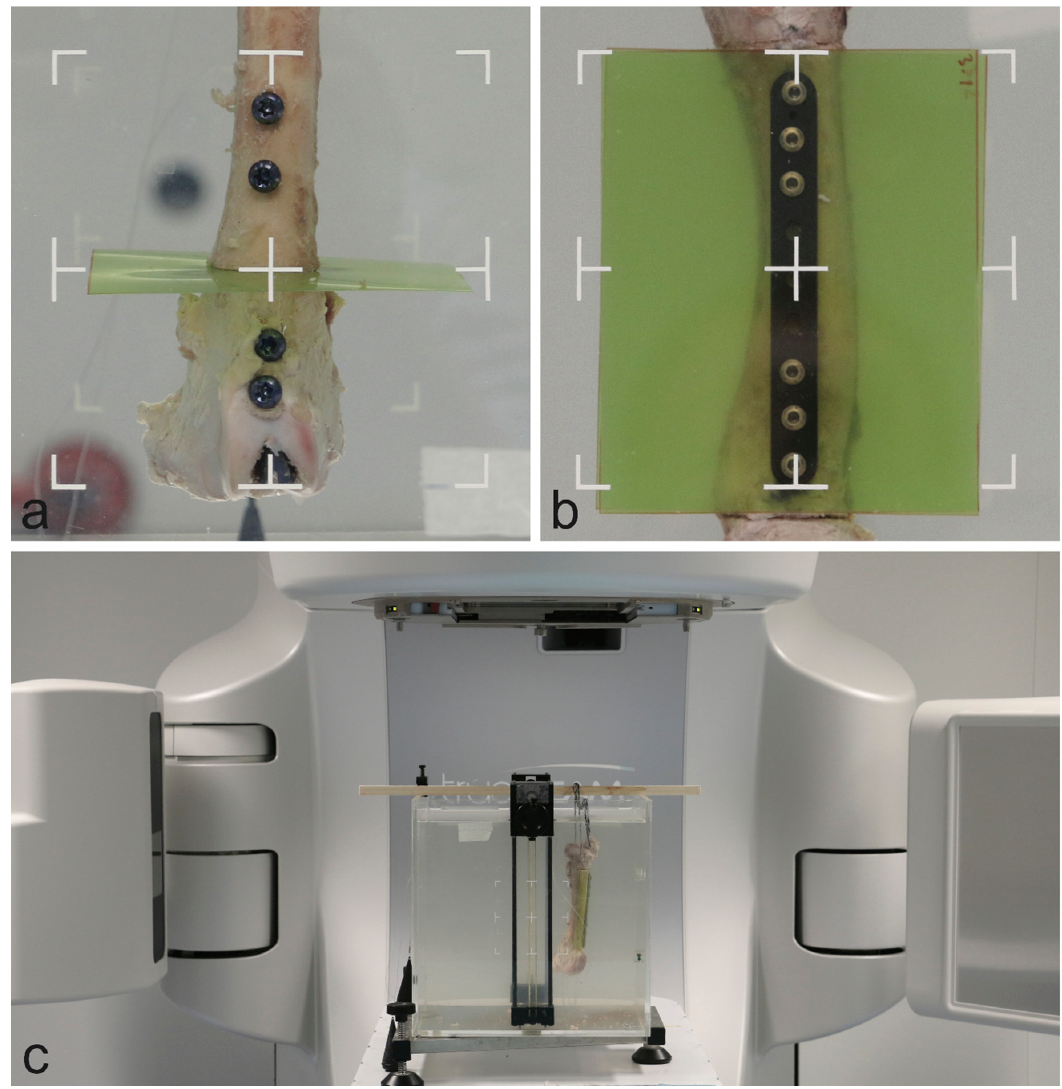
Figure 3. Specimen orientation within the water basin in the intramedullary nail model ( a ) and the plate model ( b ). Full setup within the linear accelerator ( c ).